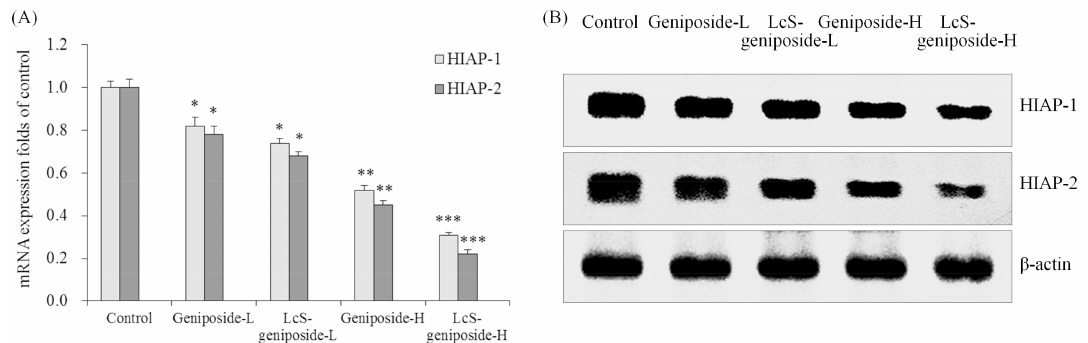
Figure 6. The mRNA ( A ) and protein ( B ) expressions of HIAP-1 and HIAP-2 in human oral squamous carcinoma HSC-3 cells. * p < 0.05, ** p < 0.01, *** p < 0.001 vs. the control group. Geniposide-L: 25 µ g/mL geniposide; LcS-geniposide-L: 1.0 × 10 6 CFU/mL LcS + 25 µ g/mL geniposide; Geniposide-H: 50 µ g/mL geniposide; LcS-geniposide-H: 1.0 × 10 6 CFU/mL LcS + 50 µ g/mL